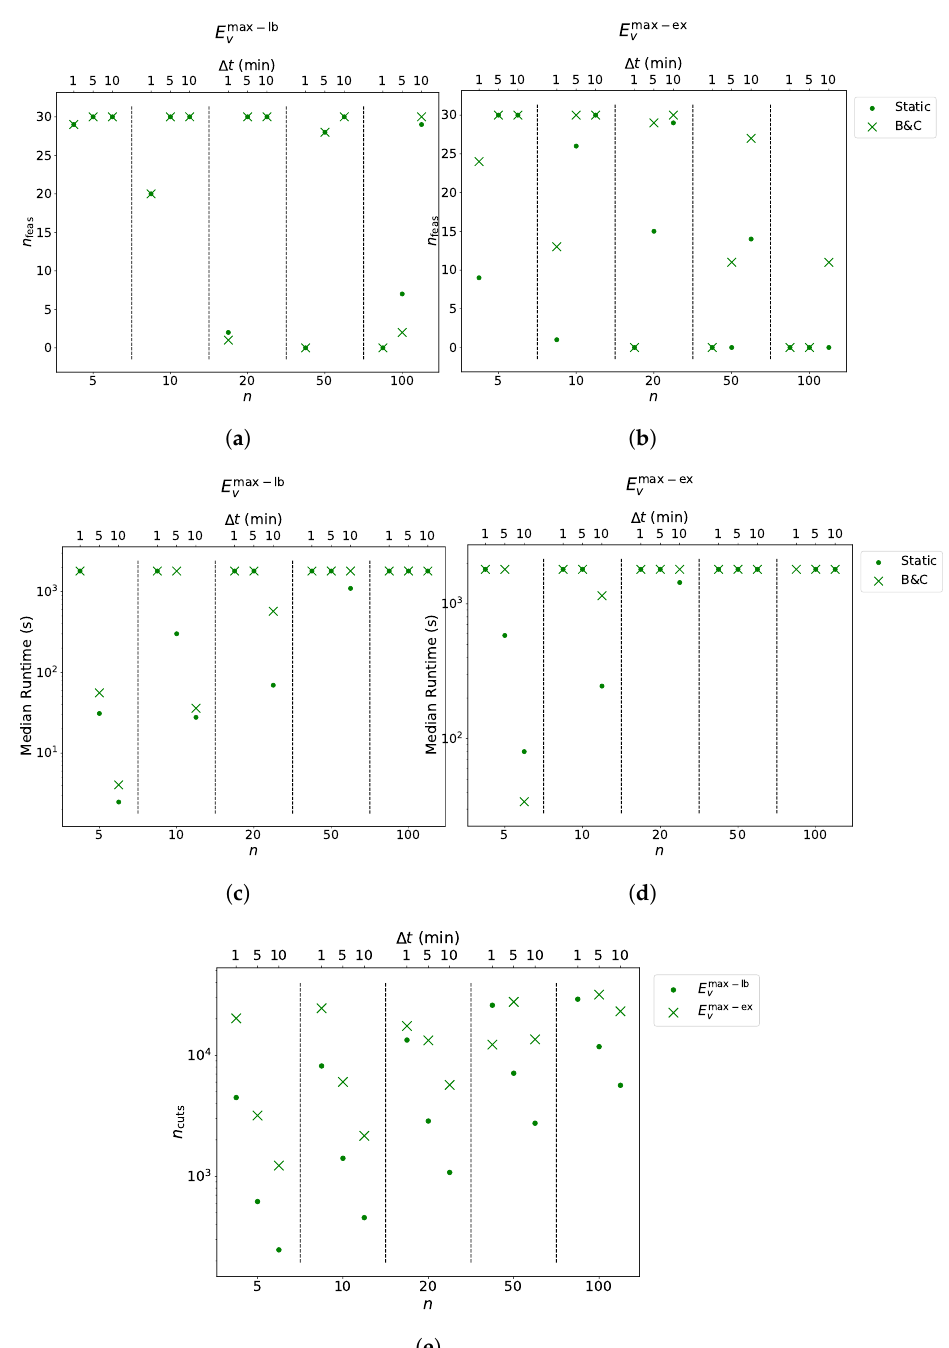
Figure 9. Visualization of EVS-SOC-GLIN results for solving the static model versus B&C with E max-lb v and E max-ex v based on five-segment piecewise linear approximations of the original P max v functions, P gridmax = 40 n . ( a ) Number of feasible solutions found for E max-lb v . ( b ) Number of feasible solutions found for E max-ex v . ( c ) Median runtimes for E max-lb v . ( d ) Median runtimes for E max-ex v . ( e ) Median number of cuts added within B&C for E max-lb v as well as E max-ex v . Only gaps of instances with a feasible solution are considered. For parameter com- binations without gaps (marked with “-”), no feasible solution has been found for any instance within the time limit. For parameter combinations where no runtime is reported, all corresponding runs terminated due to an out-of-memory error. More detailed results can be found in Appendix B where also the number of instances solved to optimality as well as standard deviations for runtimes, and the numbers of cuts are